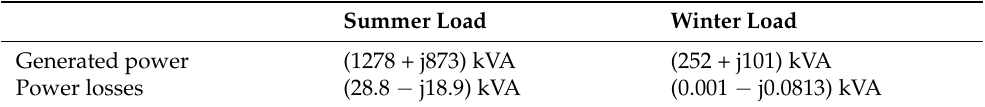
Table 12. Generated power and total losses in the diesel-only system during the winter and